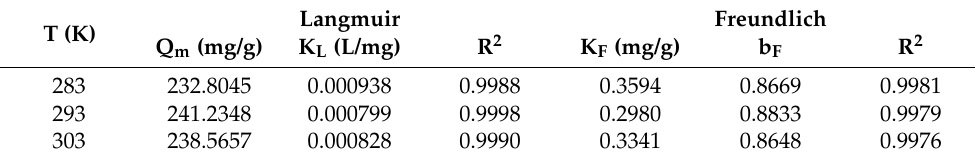
Table 3. Adsorption isotherm results for Cu(II) ions on MXCS/PAA.